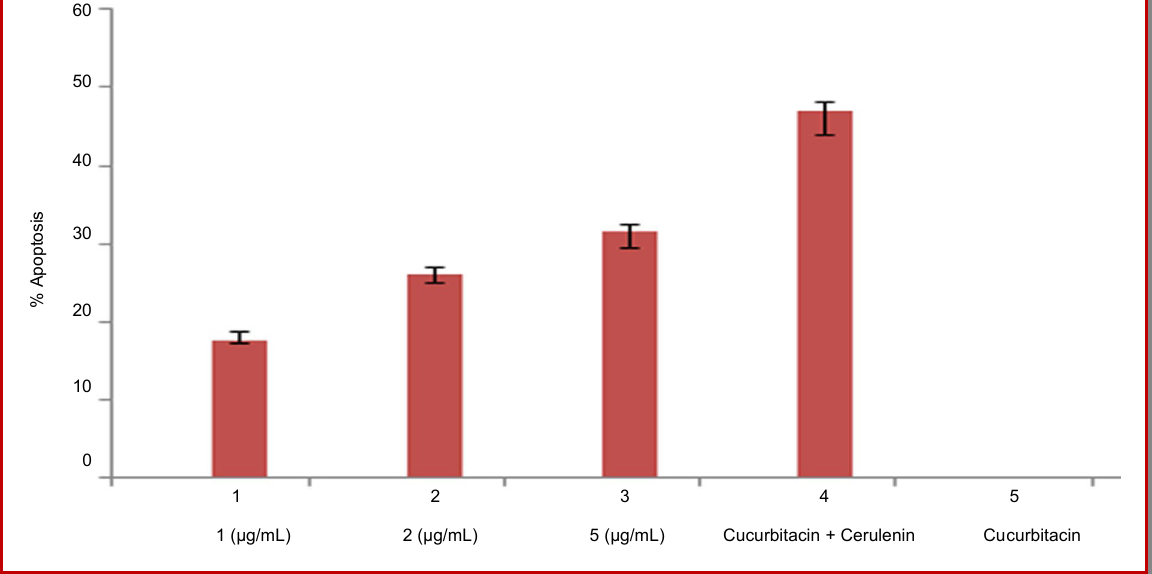
Figure 4: FACS analysis of U2-OS cells treated with epirubicin, cerulenin and the combination treatment for 24 hours. (A) Few apoptotic cells were noted in the control group. Yet, the percentage of apoptotic cells was (B) 31.5% when treated with 10 μ g/mL epirubicin and (C) 38.8% when treated with 20 μ g/mL cerulenin. (D) The percentage of apoptotic cells rose to 66.2% when treated with 10 μ g/mL epirubicin in conjunction with 20 μ g/mL cerulenin. FACS, fluorescence-activated cell sorting; PI, propidium io-